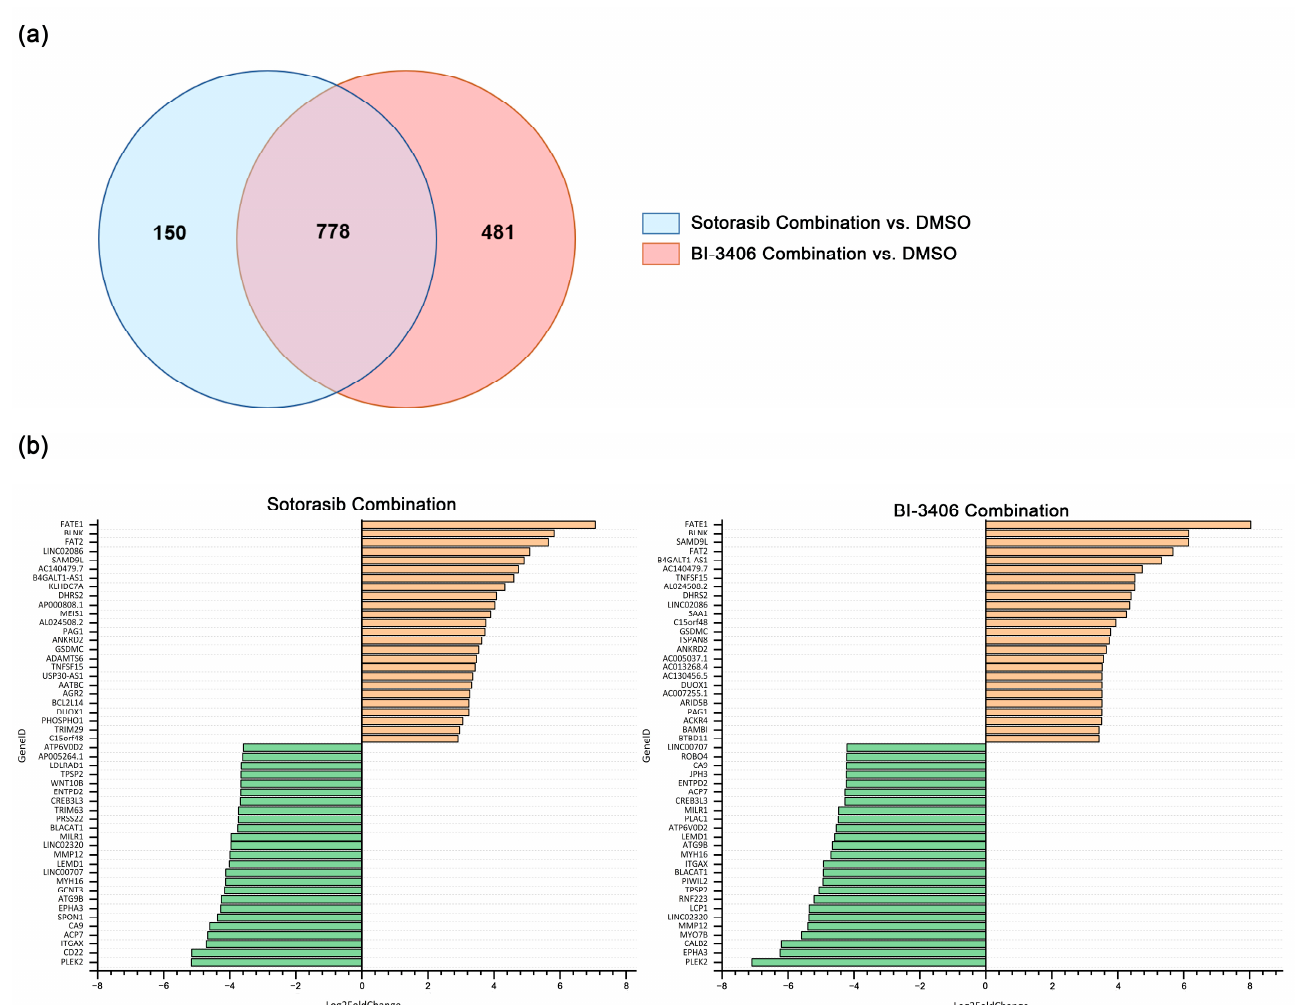
Figure 7. Number and overlap of DEGs in MIA PACA-2 cell lines after exposure to sotorasib combination or BI-3406 combination ( a ) and the top 25 up- and down-regulated genes before and after inhibitor combination exposure ( b ).